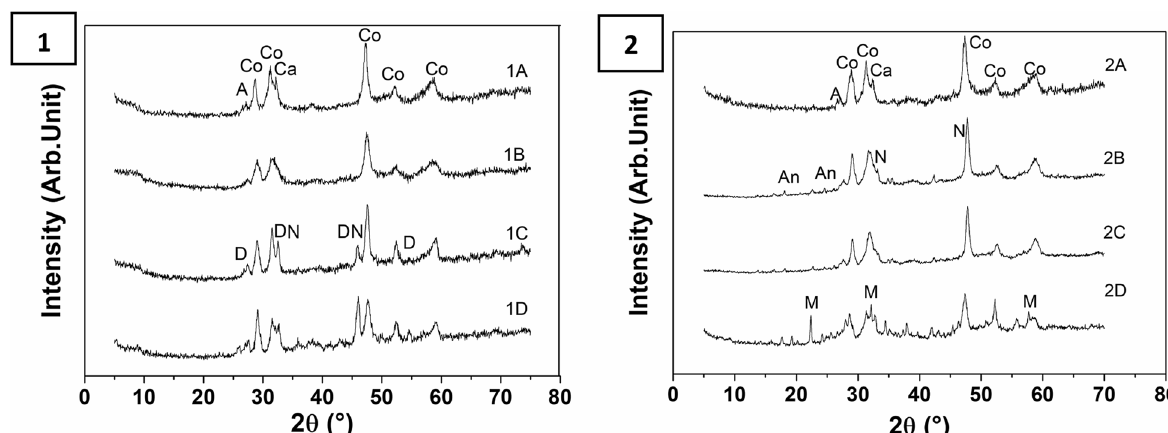
Figure 7. XRD patterns of the powder samples of helmet 1 (#) and helmet 2 (#), where # indicates the sample position from surface. ( Co Covellite, D Digenite, Ca Calcite, A Aragonite, N Nantokite, M Mushistonite, An